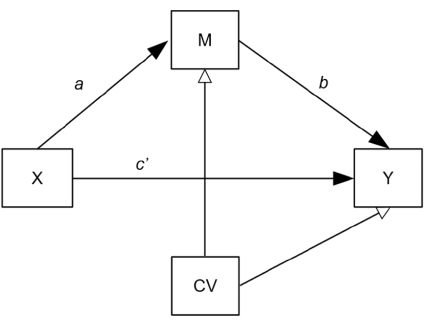
Figure 1. Mediation model pathway diagram. Mediation models assessing potential mediation effect of inflammatory protein changes on the relationship between randomisation group (metyrapone versus placebo) and treatment outcome: X = randomisation group (metyrapone or placebo), M = week 5 inflammatory marker (mediator), Y = week 5 MADRS (depression severity), CVs = week 0 inflammatory marker, week 0 depression severity, age, gender, BMI, CTQ. a path = effect of treatment on protein (week 5 adjusted for week 0), b path = effect of protein (week 5 ad- justed for week 0) on depression severity (week 5 adjusted for week 0), c’ path direct effect of treat- ment on clinical outcome.